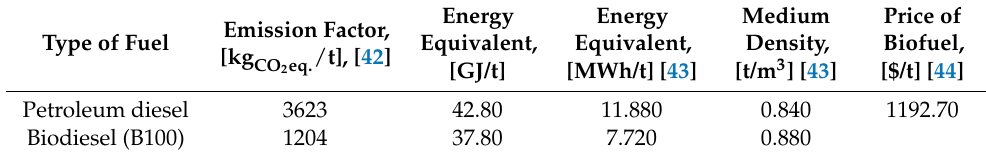
Table 5. Fuel emission factor and energy equivalent.